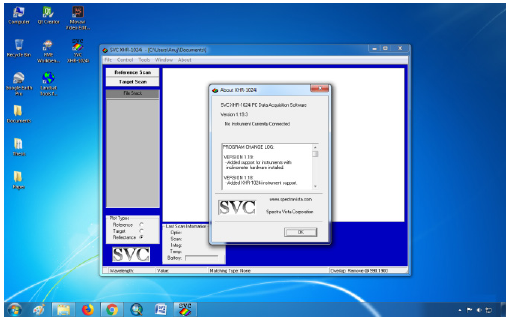
Figure 3. (b) Spectral-response visualization over SVC PC Data Acquisition software for MT-4 mango tree